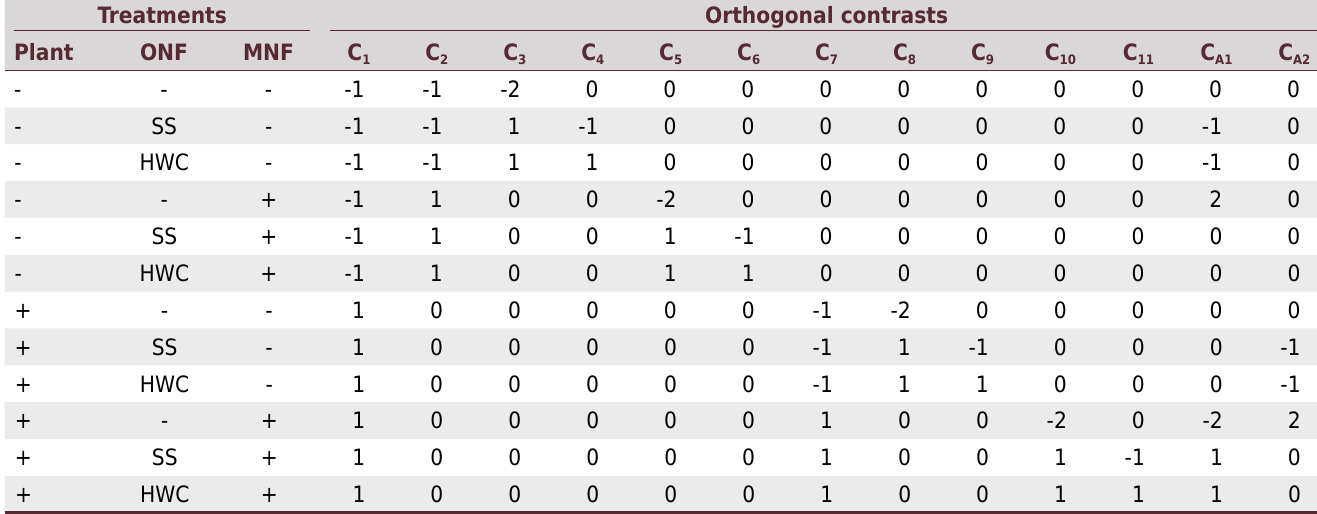
Table 3. Orthogonal (C) and additional (C A ) contrasts to different comparisons among plant, mineral-N fertilization (MNF) and organic-N fertilization (ONF) Treatments Orthogonal contrasts Plant